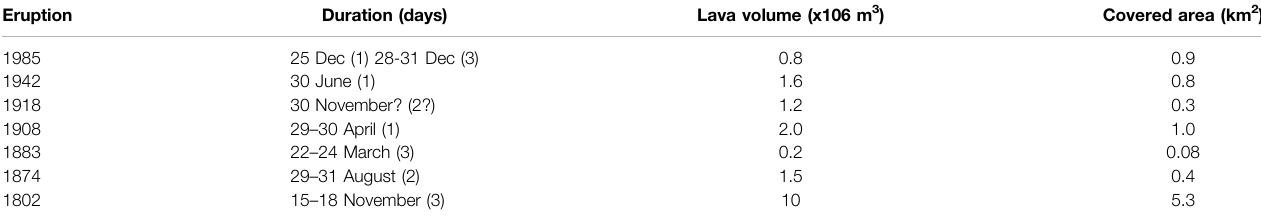
TABLE 2 | Low-volume and short-lived historic eruptions extracted from the catalogues of Etna ’ s eruptions (Behncke et al., 2005; Branca and Del Carlo, 2005). Eruption Duration (days) Lava volume (x106 m 3